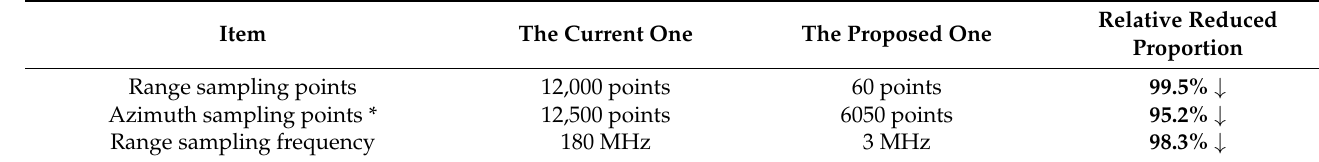
Table 4. Comparison results for the point-like